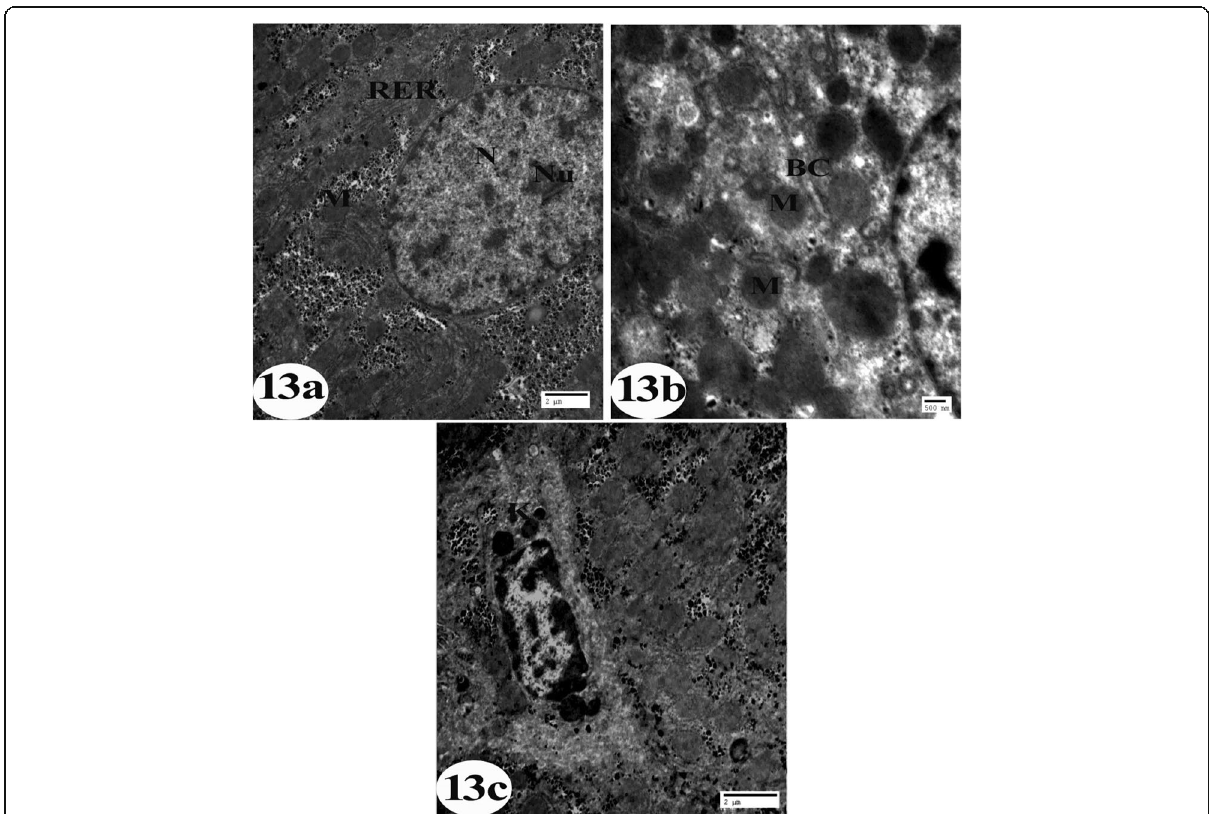
Fig. 13 Electron micrographs of a sections of liver of LCT + 200 mg ginseng/kg b. wt./day treated rats a , b showing normal hepatocyte with spherical nucleus (N) appears with a distinct nuclear envelope and prominent nucleoli (Nu), numerous mitochondria (M), rough endoplasmic reticulum (RER), and normal bile canaliculi (BC) (scale bar = 2 μ m and 500 nm respectively). c Showing normal ultrastructure of Kuppfer cell (K) (scale bar = 2 μ